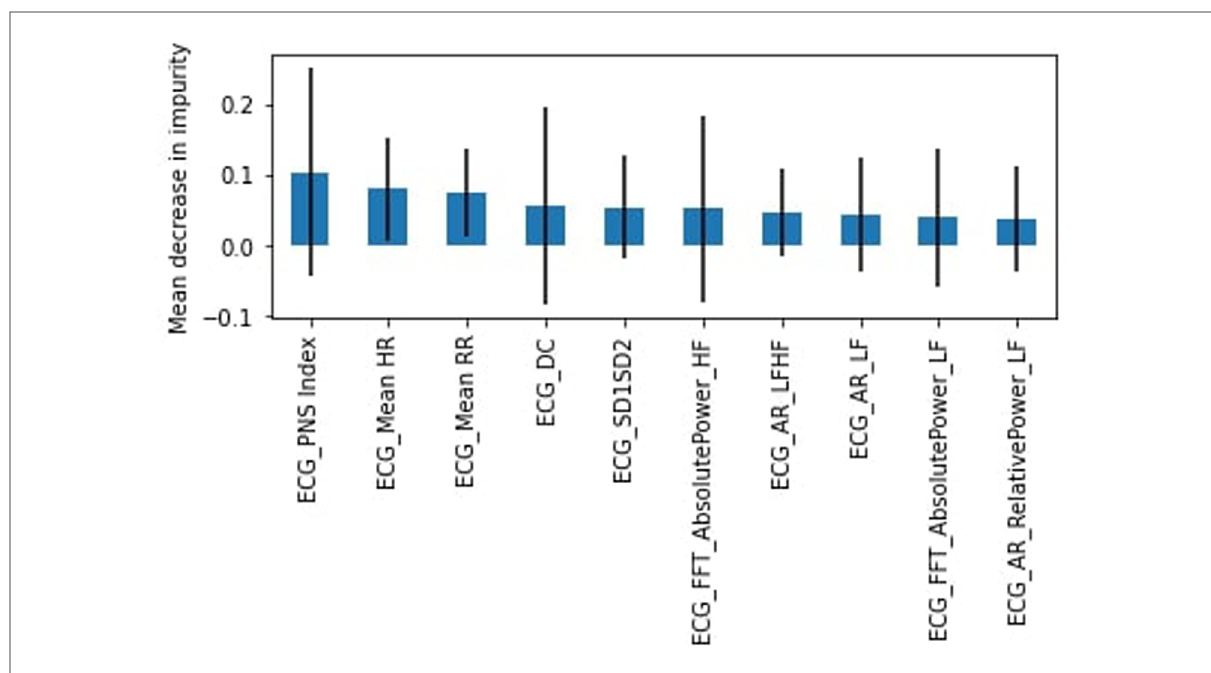
FIGURE 10 RF feature importance, male participants.